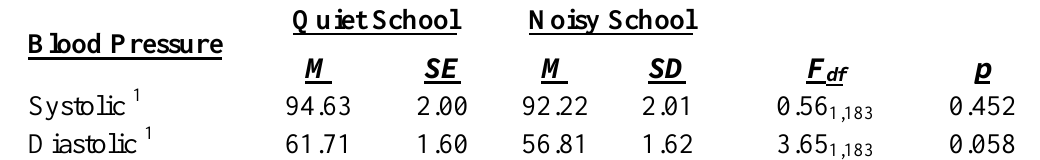
Table 1. Resting systolic and diastolic blood pressure among children in the quiet versus noisy elementary school (n =